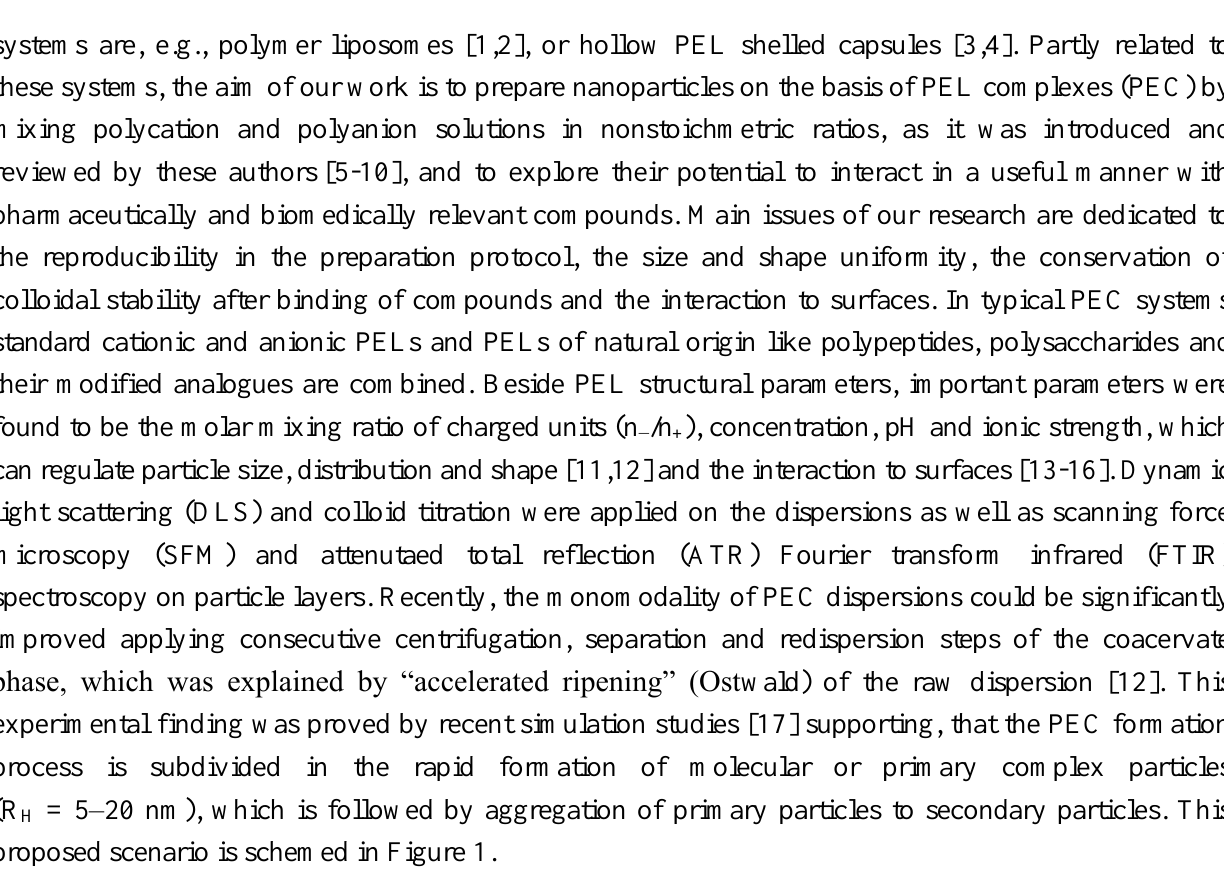
Figure 1. (From [18] with kind permission of Research Trends) Scheme of the polyelectrolyte (PEL) complex (PEC) formation process supported by experiment and simulation